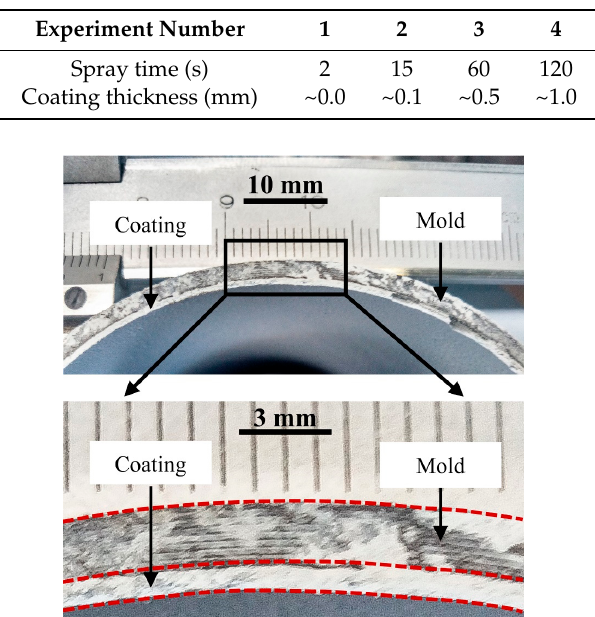
Figure 2. Photograph of boron nitride (BN) coating (~1 mm) on internal mold surface. The boundary of the mold and coating is marked by the red dashed line.